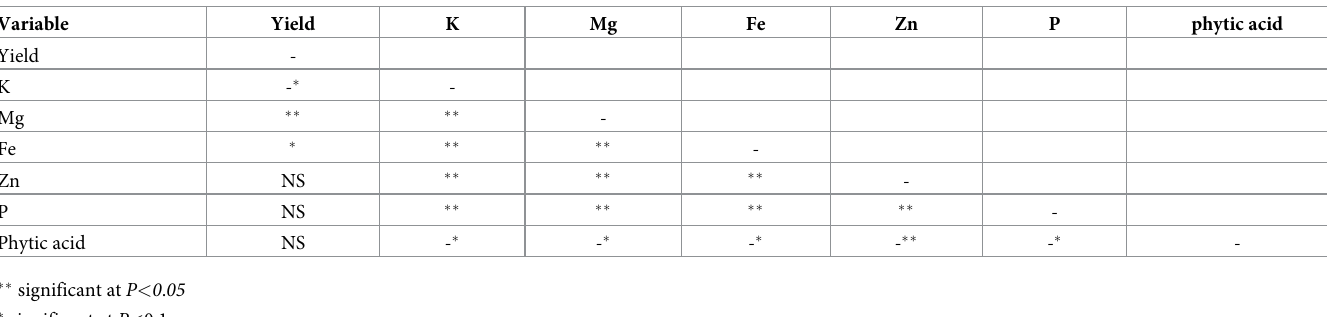
Table 7. Correlation of yield, critical minerals, and phytic acid concentrations of organic dry pea genotypes. Variable Yield K Mg Fe Zn P phytic acid Yield - K - � - Mg �� �� - Fe � �� �� - Zn NS �� �� �� - P NS �� �� �� �� - Phytic acid NS - � - � - � - �� - � - �� significant at P < 0 . 05 � significant at P <